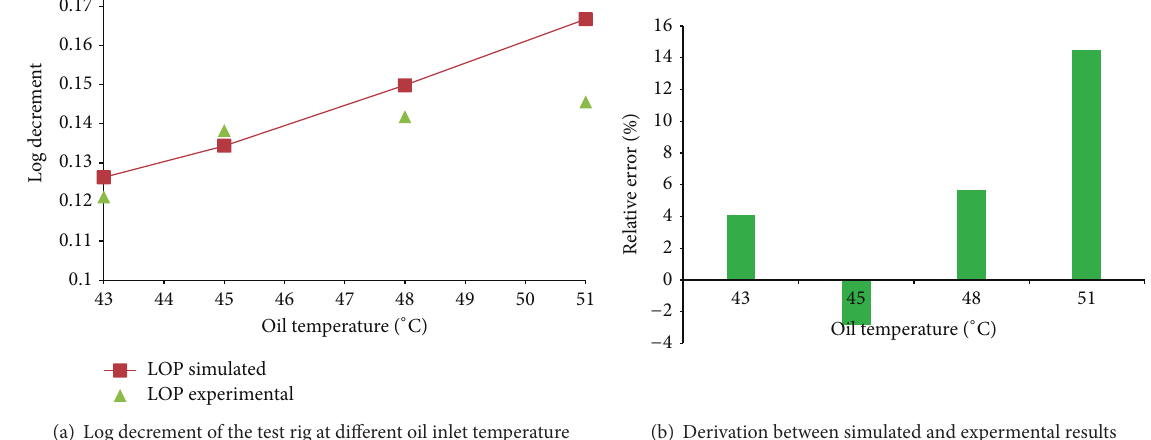
Figure 10: Log decrement of rotor-bearing system at different oil inlet temperature (preload 0.1).